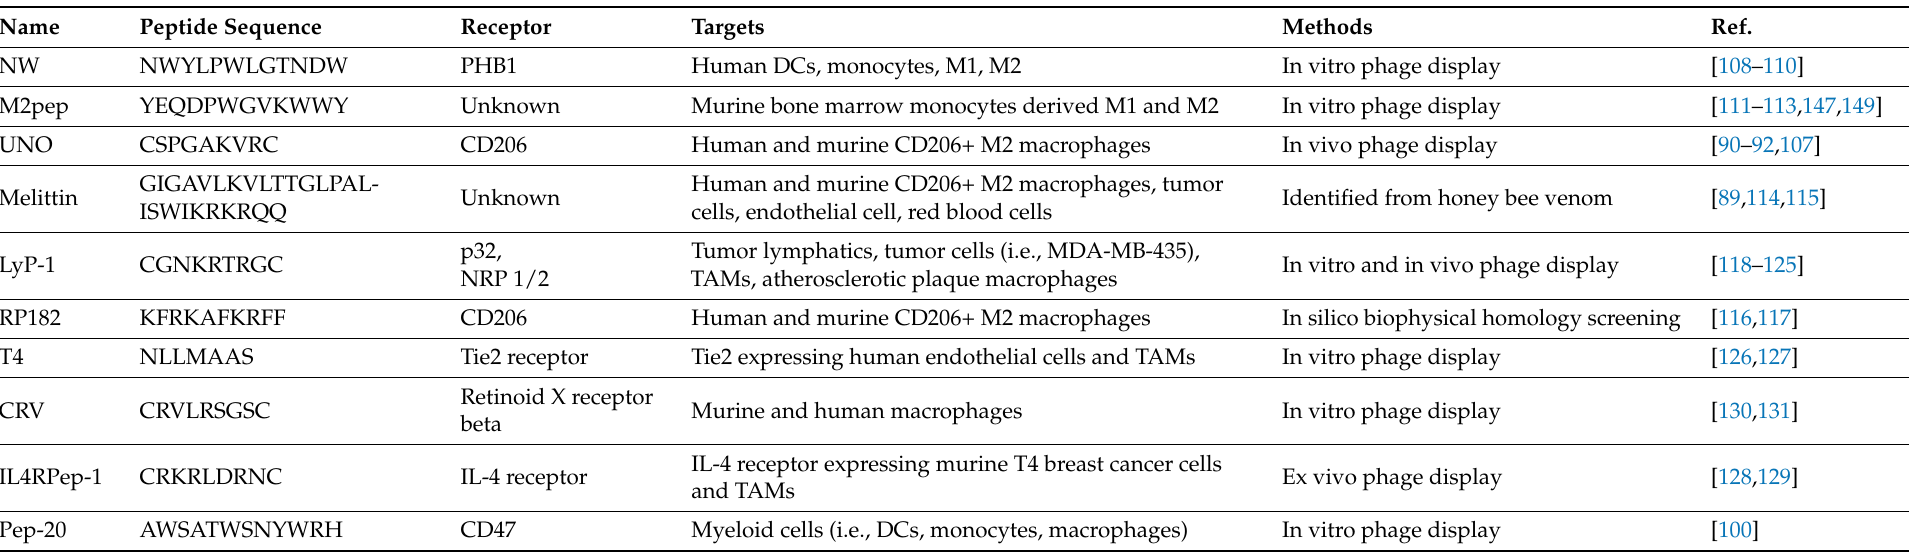
Table 4. Examples of TAM targeting